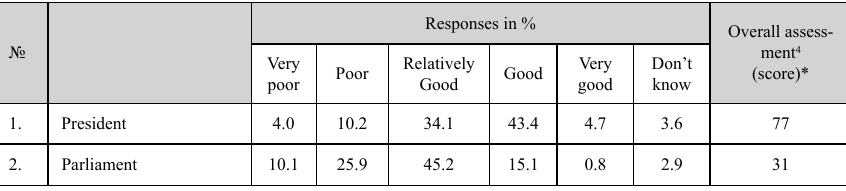
Table 5. Public Perception of Activities of State